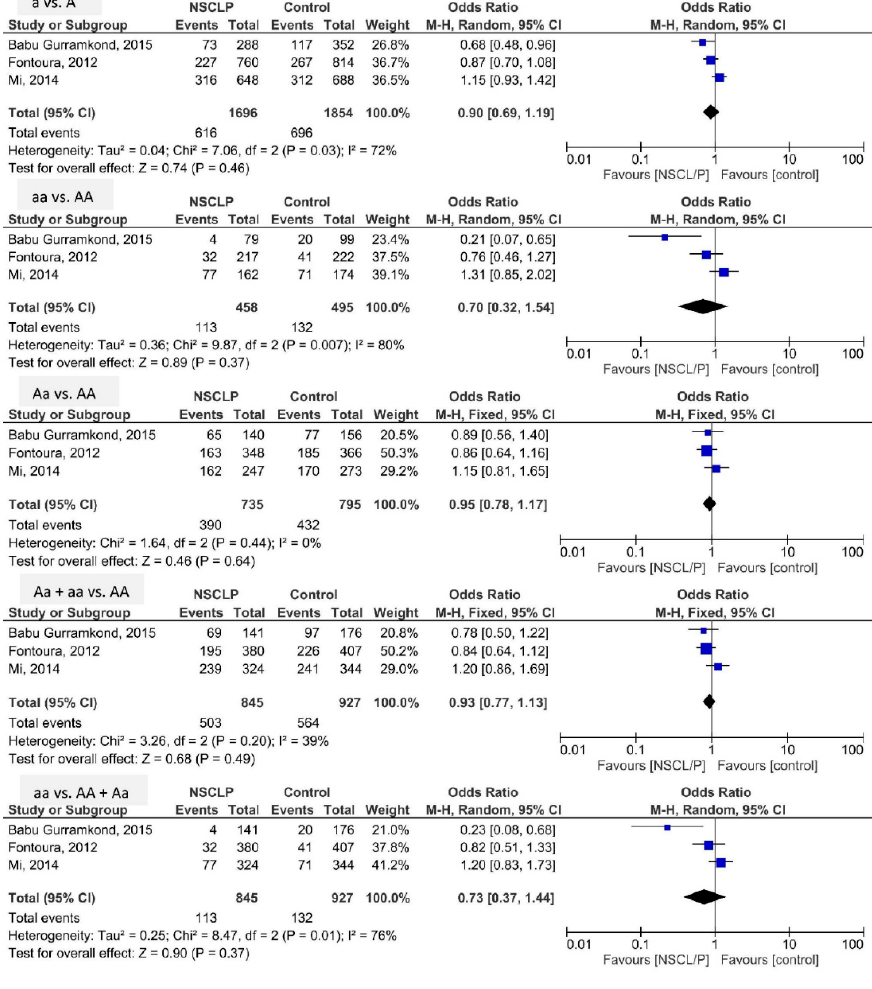
Table 2. Subgroup analysis of the risk of non-syndromic cleft lip / palate related to rs13041247 MAFB